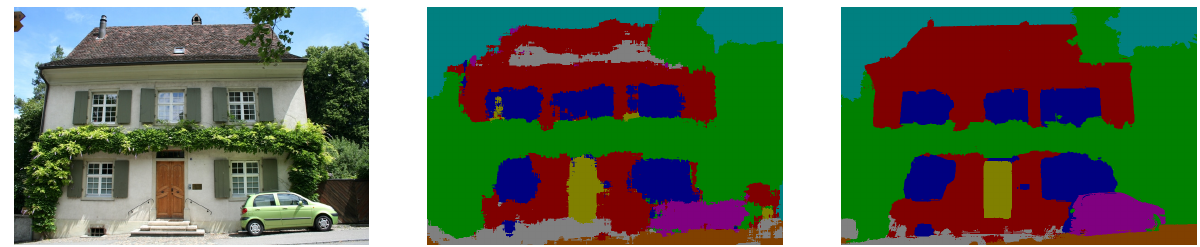
Figure 2. The pipeline of our method: first, we train Textonboost as the unary classifiers for each pixel; second, we run mean-field inference of fully connected CRF to get maximum posterior marginal